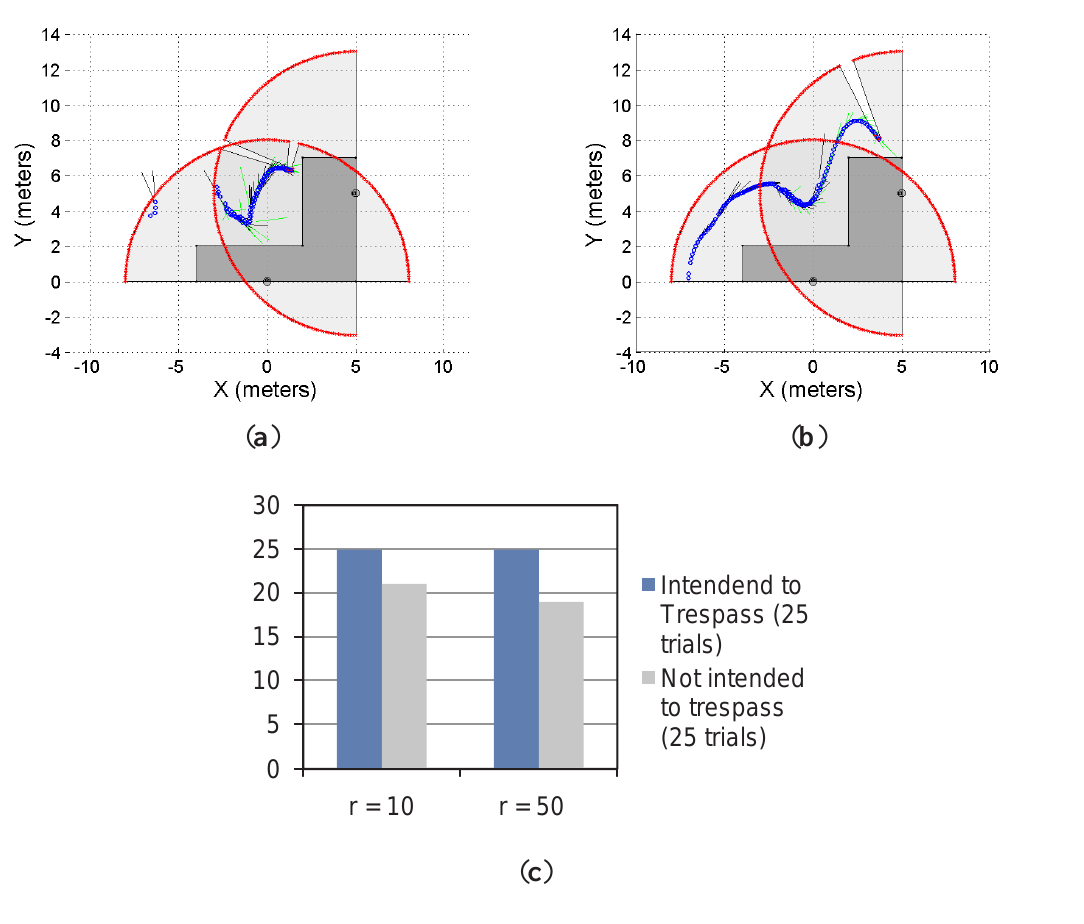
Figure 9. Single object prediction by a multi-laser disposition. ( a , b ) two examples of the performed experiment; ( c ) the statistical results of the experiment.